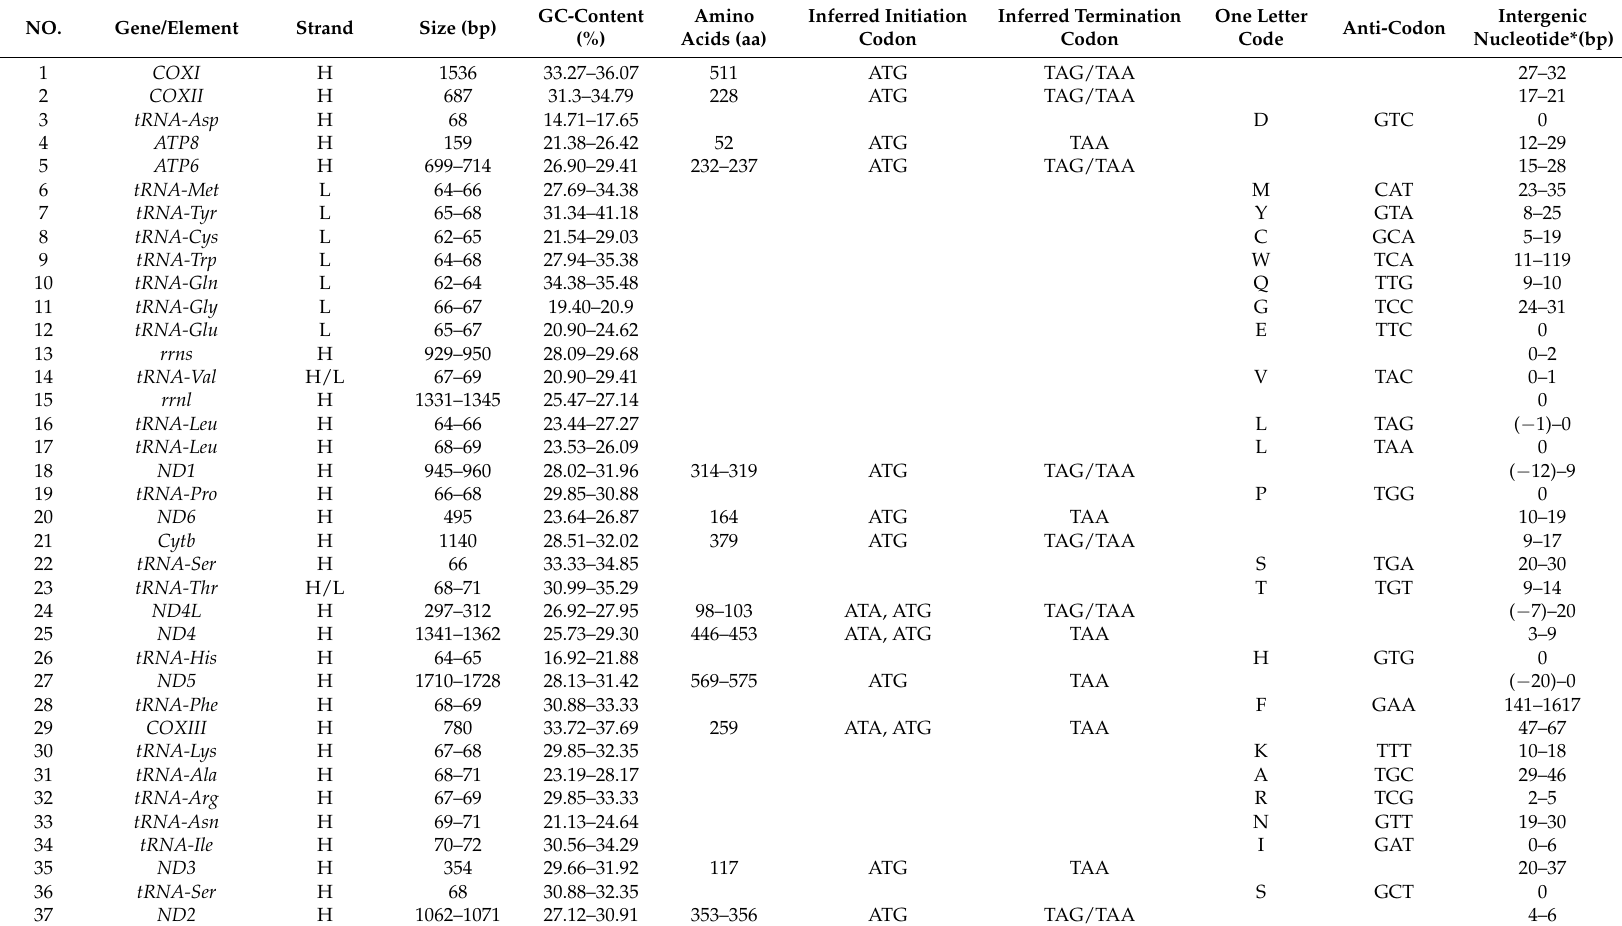
Table 1. Summary of gene/element feature of P. canaliculata , P. diffusa and P. maculate